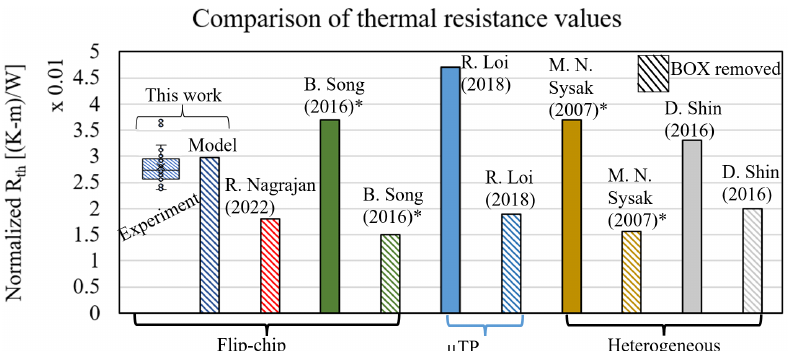
Figure 10. Thermal resistance from experiments, model, and values from literature. R. Nagarajan (2022) [21] and B. Song (2016) [20] report results on flip-chip integrated lasers. R. Loi (2018) [11] reports µprinted lasers and M.N. Sysak (2007) [7] and D. Shin (2016) [19] report on heterogeneous laser integration. The thermal resistance was normalised as the laser length × thermal resistance product. Results indicated with ∗ are simulation results.